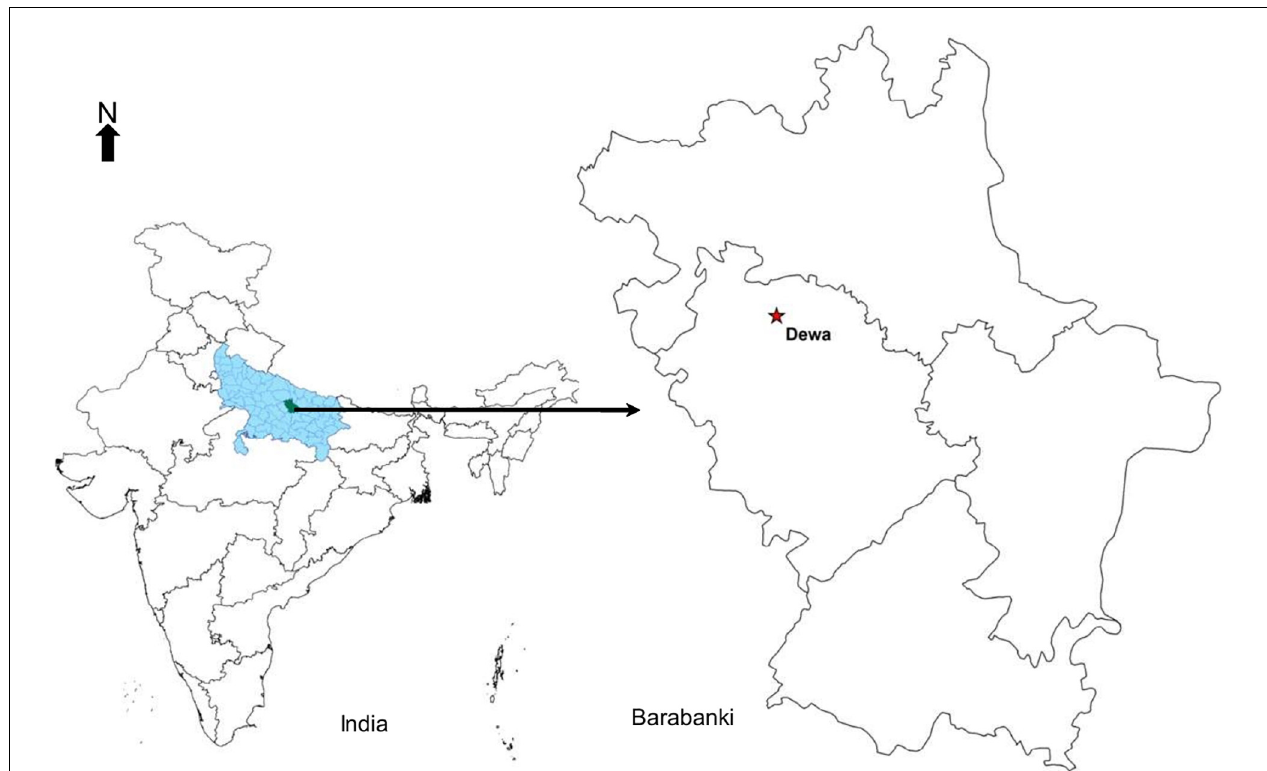
FIGURE 1 | Location of the experimental